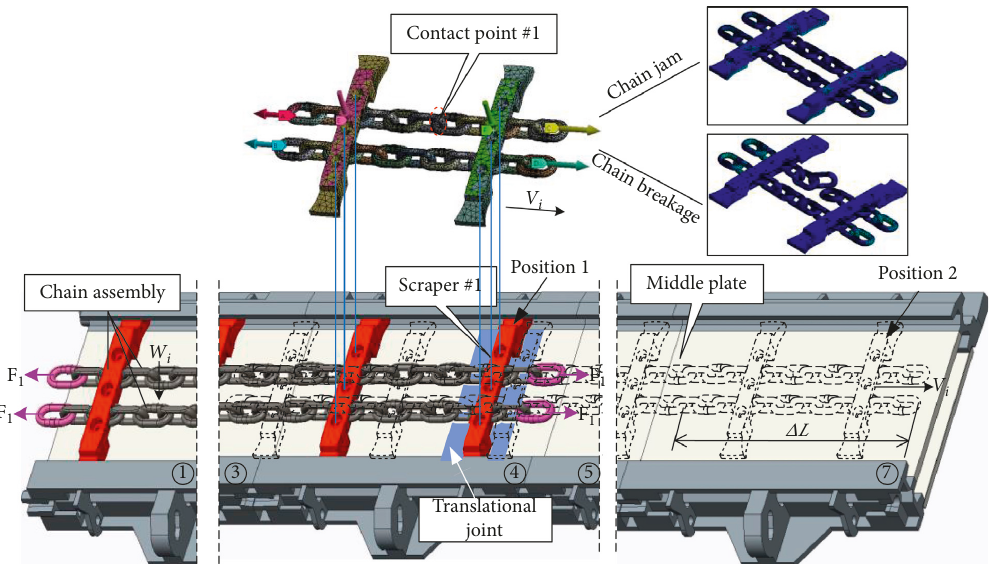
Figure 5: Simulation process of the